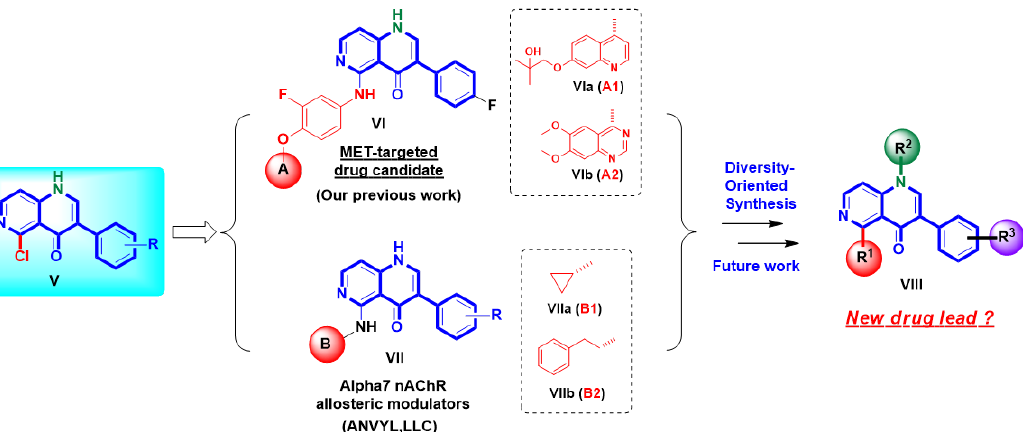
Figure 2. Discovery of bioactive 5-amino-3-phenyl-1,6-naphthyridin-4-one derivatives VI , VII and proposed future work.